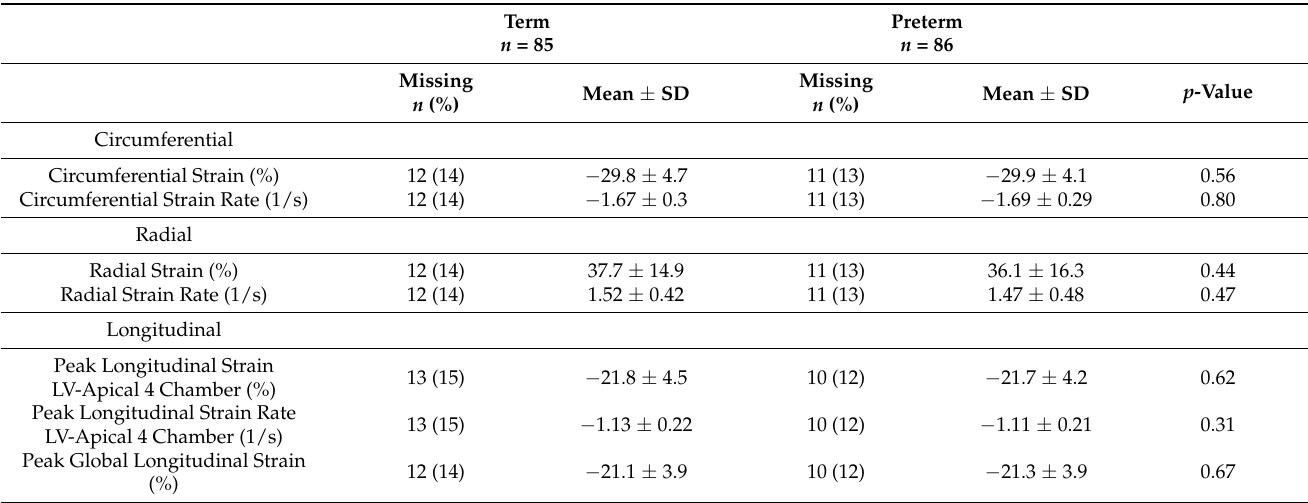
Table 4. Speckle-Tracking Echocardiography.